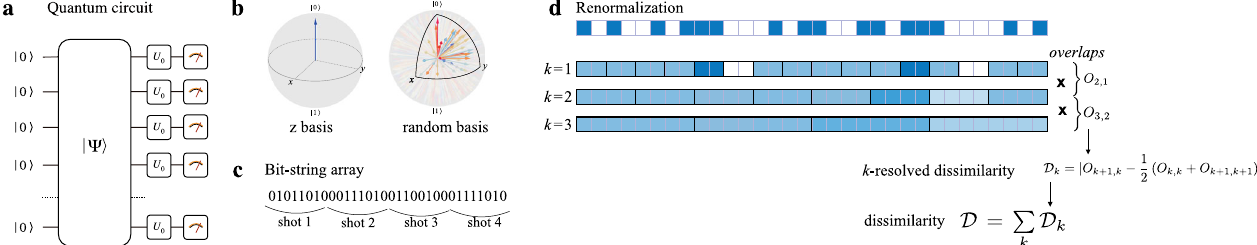
Fig. 1 Protocol for computing dissimilarity of a quantum state. a First, one prepares a state on a quantum device and chooses the measurement basis by applying rotational gates U 0 to individual qubits. b In this paper, we work with σ z and random bases whose Bloch sphere representations are shown in the picture. We say that the set of measurements is performed in a random basis if, for each shot of measurement, a random vector belonging to the highlighted sector of the Bloch sphere is uniformly sampled and the corresponding parameters of gate U 0 are applied. c A number of measurements is performed and their outcomes — bitstrings of length N — are then stacked together in a one-dimensional binary array of length N × N shots that serves as a classical representation of the quantum state. d The array is coarse-grained in several steps (indexed with k ). Different schemes can be employed, but here we use plain averaging with fi xed fi lter size Λ . In the picture, blue and white squares in the top line correspond to ‘ 0 ’ and ‘ 1 ’ bits in the array shown in ( c ), and black rectangles depict the blocks where averaging occurs at every step of coarse-graining. Overlap-based dissimilarities D k between subsequent arrays are computed and summed up to the overall dissimilarity D . See Methods section for more